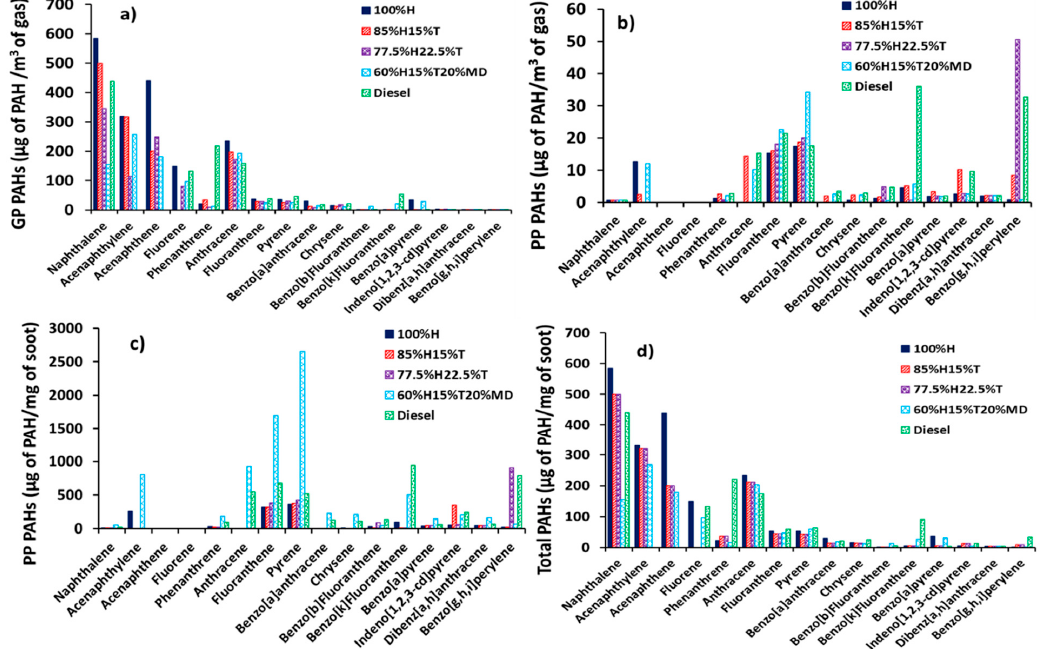
Figure 3. The distributions of exhaust PAHs in diesel engine: ( a ) Gas Phase (GP, µg of PAH/m 3 of gas), ( b ) Particle Phase (PP, µg of PAH/m 3 of gas), ( c ) Particle Phase (ng of PAH/mg of soot) and ( d ) total PAHs (GP + PP, µg of PAH/m 3 of gas).